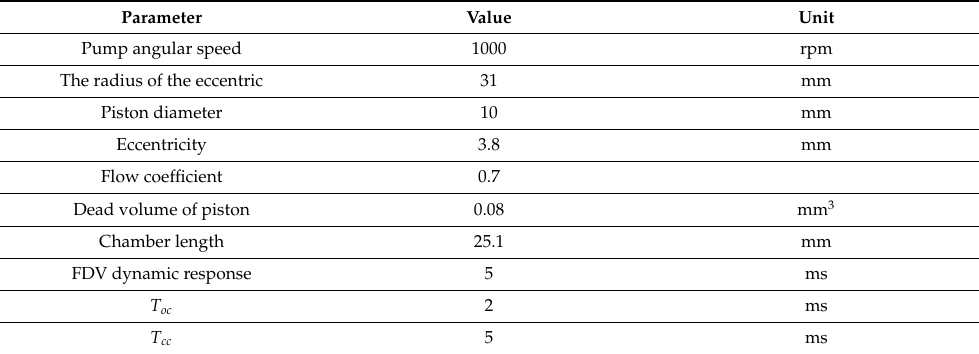
Table 1. Main performance parameters.